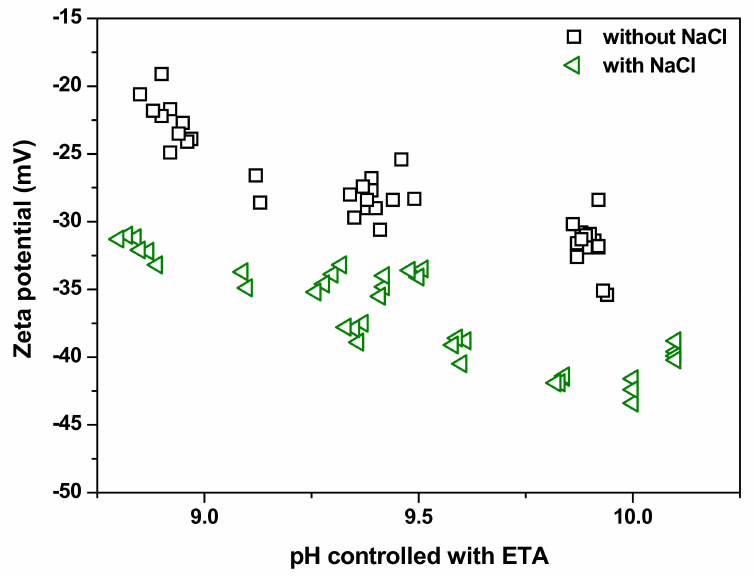
Figure 5. Zeta potentials of magnetite nanoparticles in solutions with and without NaCl addition as a function of pH value, controlled with ETA at 25 ◦ C.